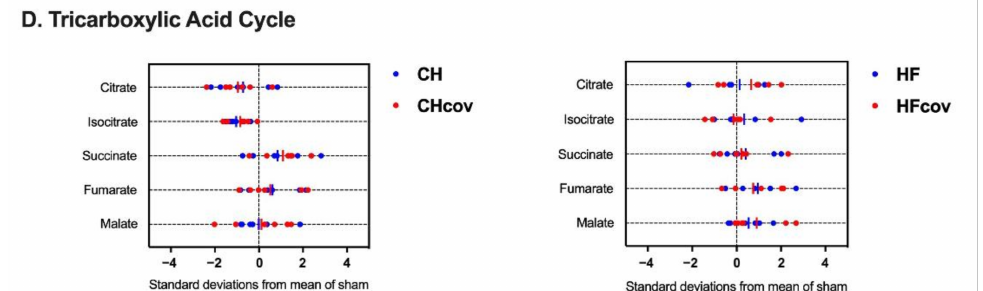
Figure 4. Changes in the myocardial levels of ( A ) glycolysis intermediates, ( B ) hexosamine biosyn- thetic pathway intermediates, ( C ) acylcarnitines, and ( D ) tricarboxylic acid cycle intermediates in volume-overloaded rats in the compensated hypertrophic (CH) and heart failure (HF) phases and in volume-overloaded rats with correction of volume overload in the CH (CH COV ) and HF phases (HF COV ) compared to those in the corresponding sham controls. In each z-score plot, the data are shown as standard deviation from the mean of sham. Each dot represents a single metabolite in each sample. The vertical lines represent the means of z-scores. n = 6 per group. Blue, red, and green stars denote comparison between CH or HF vs. sham, CH COV or HF COV vs. sham, and CH vs. HF, respectively. *, **, and *** denote p < 0.05, p < 0.01, and p < 0.001,